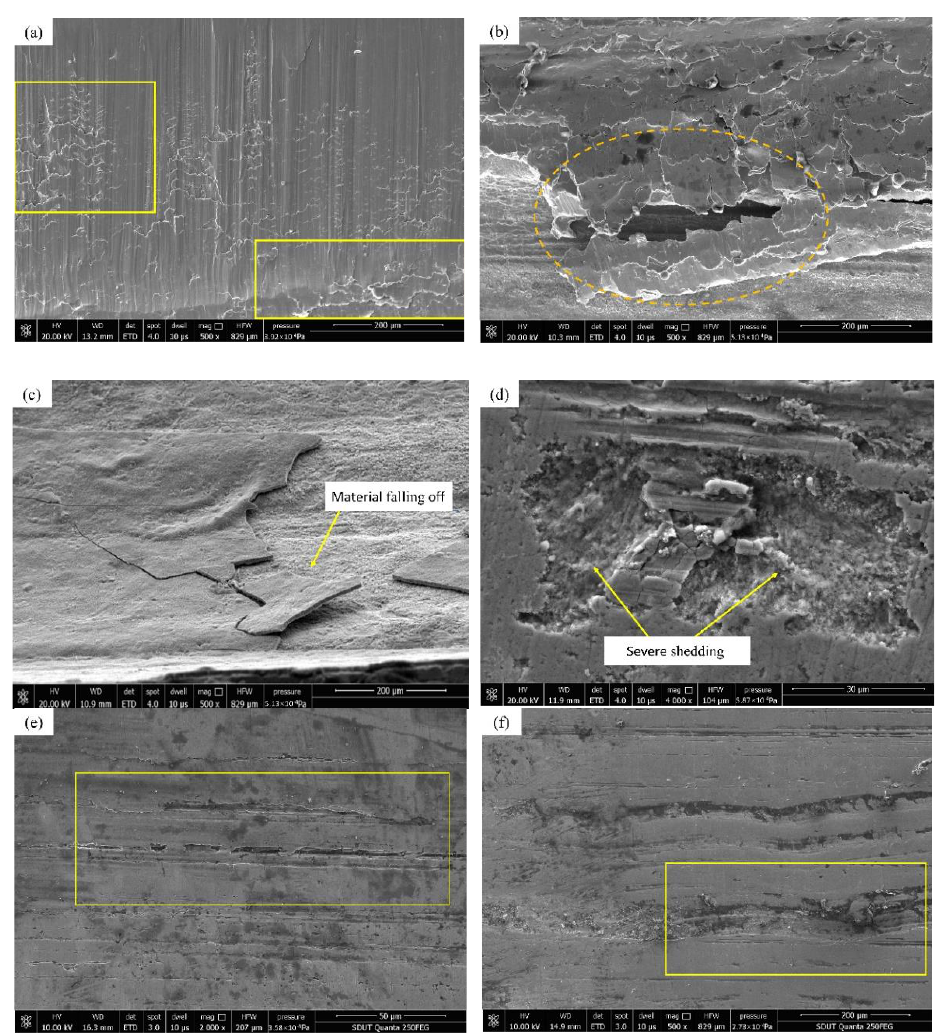
Figure 9. Micro appearance map of the teeth; ( a ) plastic deformation of tooth surface; ( b ) hardening of the tooth surface; ( c ) surface material falling off at the tooth root; ( d ) pit formed by large area of material falling off; ( e ) the groove at the pitch line of the control gear; ( f ) crushing deformation of the gear tooth root in the control group.